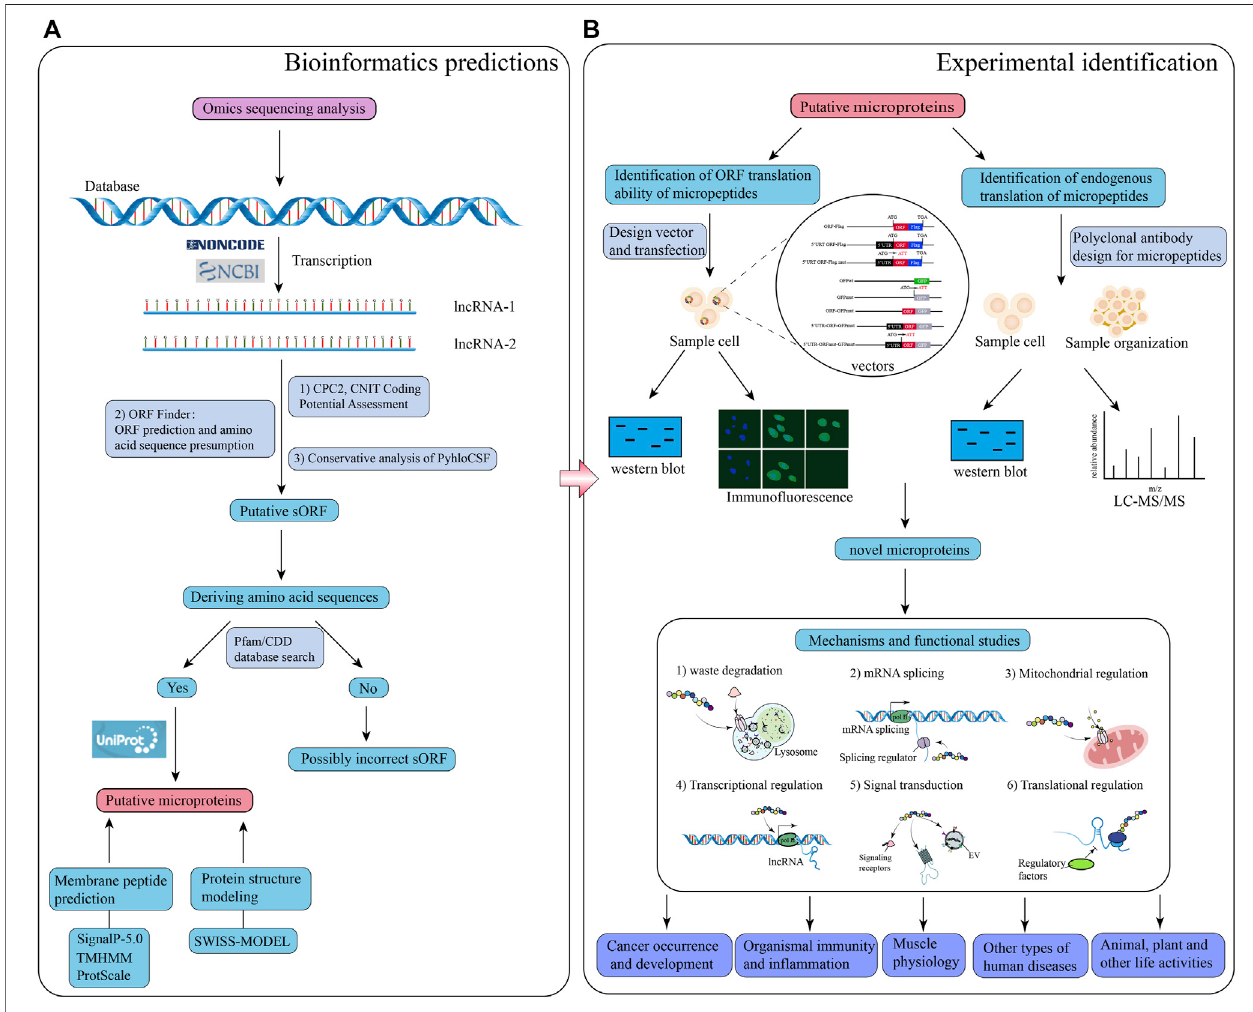
FIGURE 1 | Schematic illustration of the work fl ow for bioinformatics prediction and experimental analysis of lncRNA-encoded micropeptides. (A) Bioinformatics prediction: fi rstly, construct a database of putative lncRNA-encoding micropeptides by applying the results of omics sequencing, and search the putative lncRNA sequences with coding potential through NCBI or NONCODE database; secondly, use calculation tools, and databases such as CPC2, CNIT, ORF Finder, PyhloCSF, etc. to evaluate the coding potential of the putative lncRNA, and deduce the corresponding sORF, and amino acid sequence; thirdly, the deduced amino acid sequenceswereputintothePfamandCDDdatabasestolookforthem,andiftheymatched,thesearchfortheputativemicropeptideinformationwascontinuedthrough theUniProtdatabase; fi nally,thecharacteristicsandstructureoftheputativemicropeptidewerepredictedandmodeledthroughcalculationtoolsanddatabasessuchas SignalP-5.0, TMHMM, ProtScale and SWISS-MODEL; (B) Laboratory identi fi cation: design a series of special vectors to be transfected into speci fi c cells, and apply western blot and immuno fl uorescence experiments to identify micropeptides; meanwhile, polyclonal antibodies to this micropeptide were designed, and detected by westernblotandLC-MS/MSexperimentsonsamplecellsandtissues.Basedontheresultsofbothexperimentalprocedures,theputativemicropeptidewasidenti fi edas a novel micropeptide, and then the function and mechanism of the micropeptide were